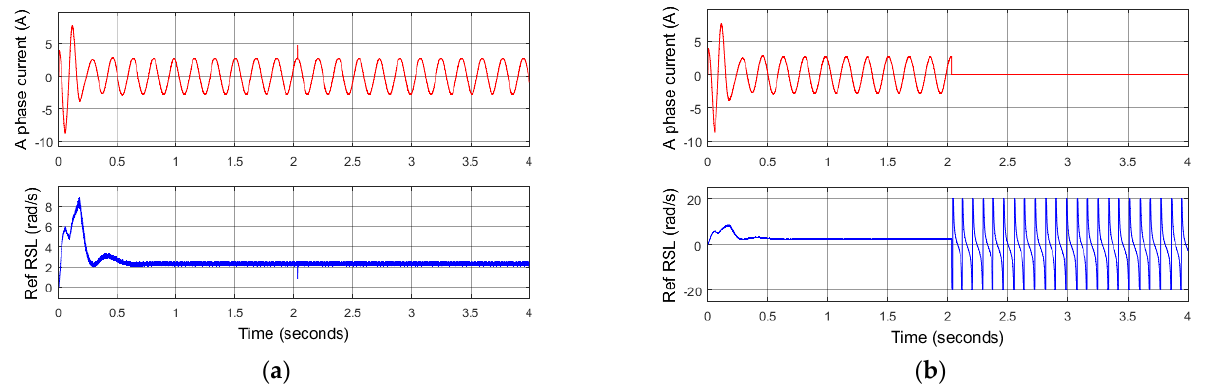
Figure 7. Simulation results: changes of reference RSL signal in cases. ( a ) Random noise of A phase current signal; ( b ) total fault of A phase current sensor.